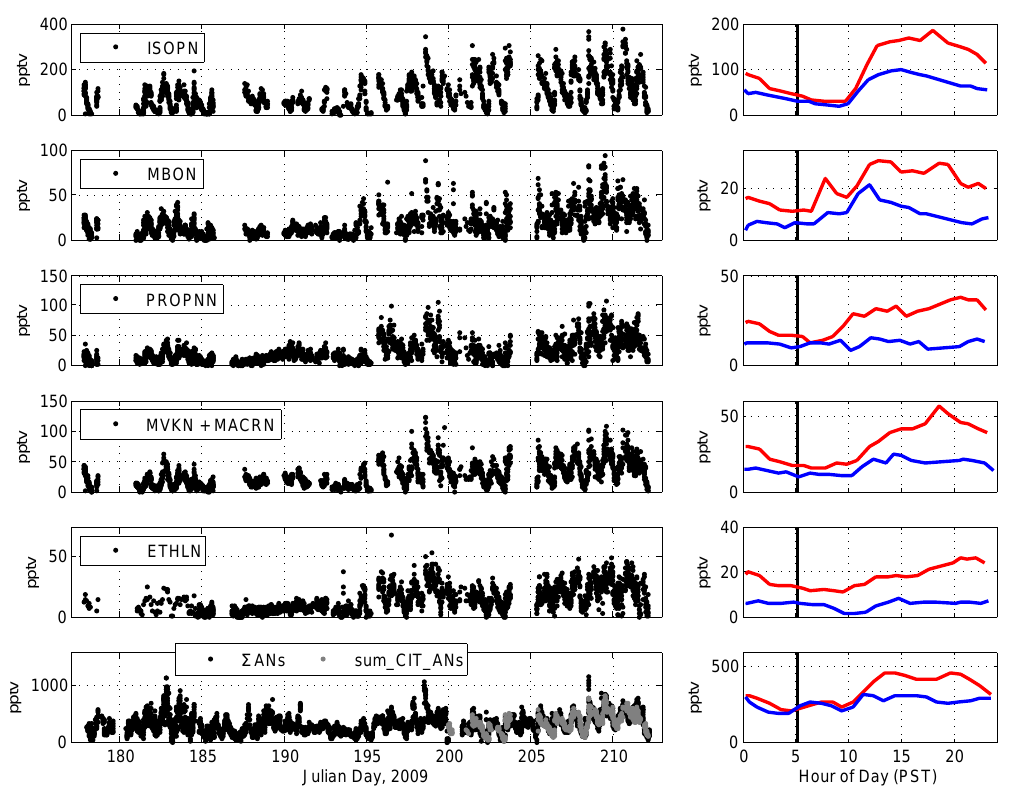
Fig. 2. Time series (left) and mean diurnal profiles (right) of organic nitrates and 6 ANs measured during BEARPEX 2009. Diurnal profiles shown in red are mean concentrations on days with maximum daytime temperatures of 26°C and higher. Blue diurnal profile is the mean concentration on days with maximum temperatures less than 26°C. Vertical lines indicate local